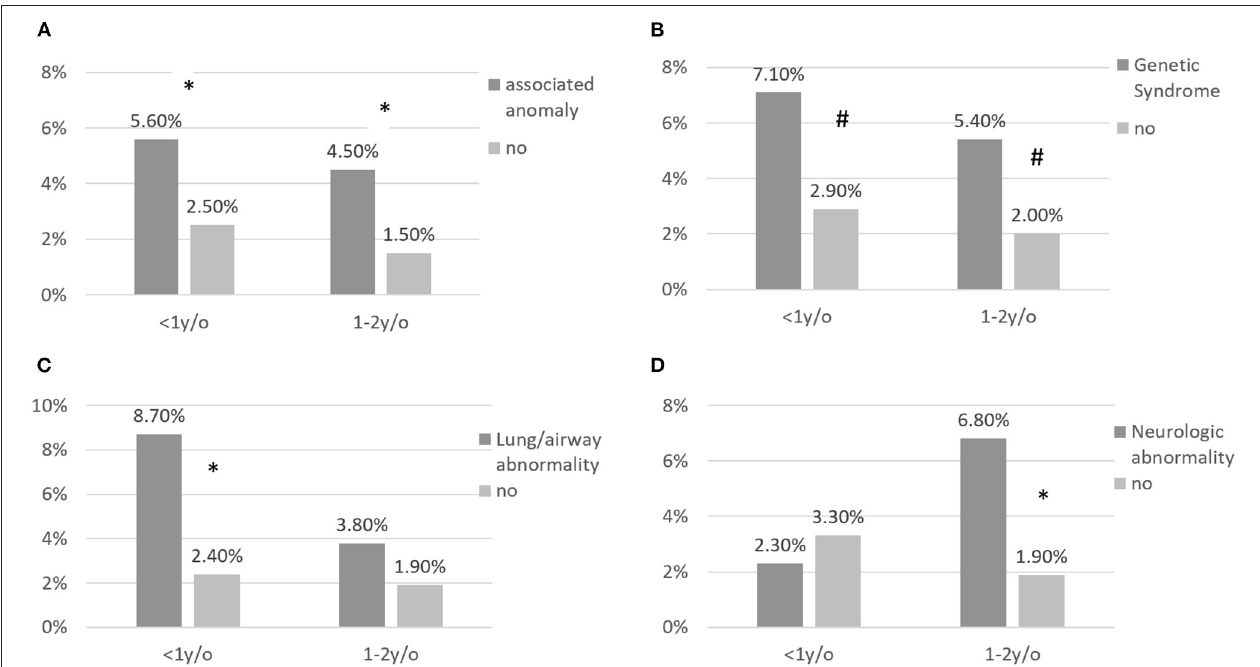
FIGURE 1 | (A–D) RSV-related hospitalization for children with CHD according to associated abnormalities and stratified by age at infection. RSV-related hospitalization rates were significantly higher for patients with associated abnormalities aged < 1 and aged > 1 and < 2 years. * annotates p < 0.05; # annotates p <